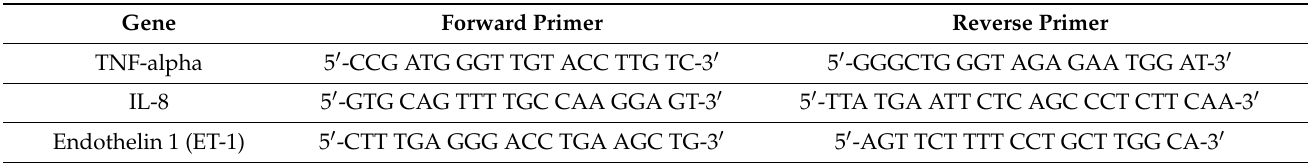
Table 1. List of